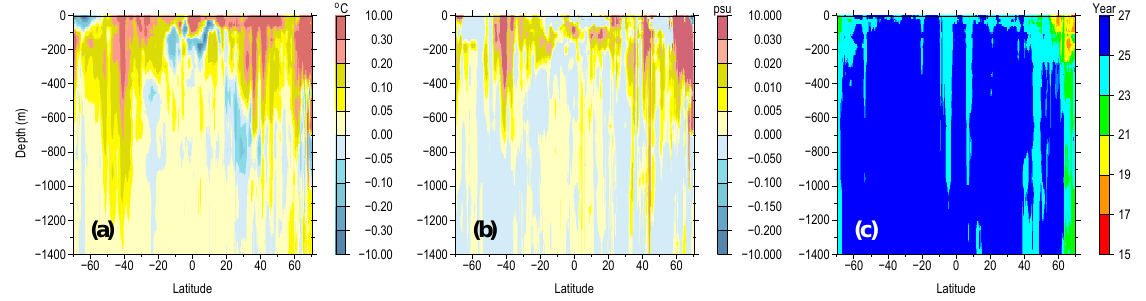
Figure 14. Zonally averaged differences between the WAGHC and WOA13 climatologies for temperature (a) , salinity (b) , and mean clima- tological year (c) .